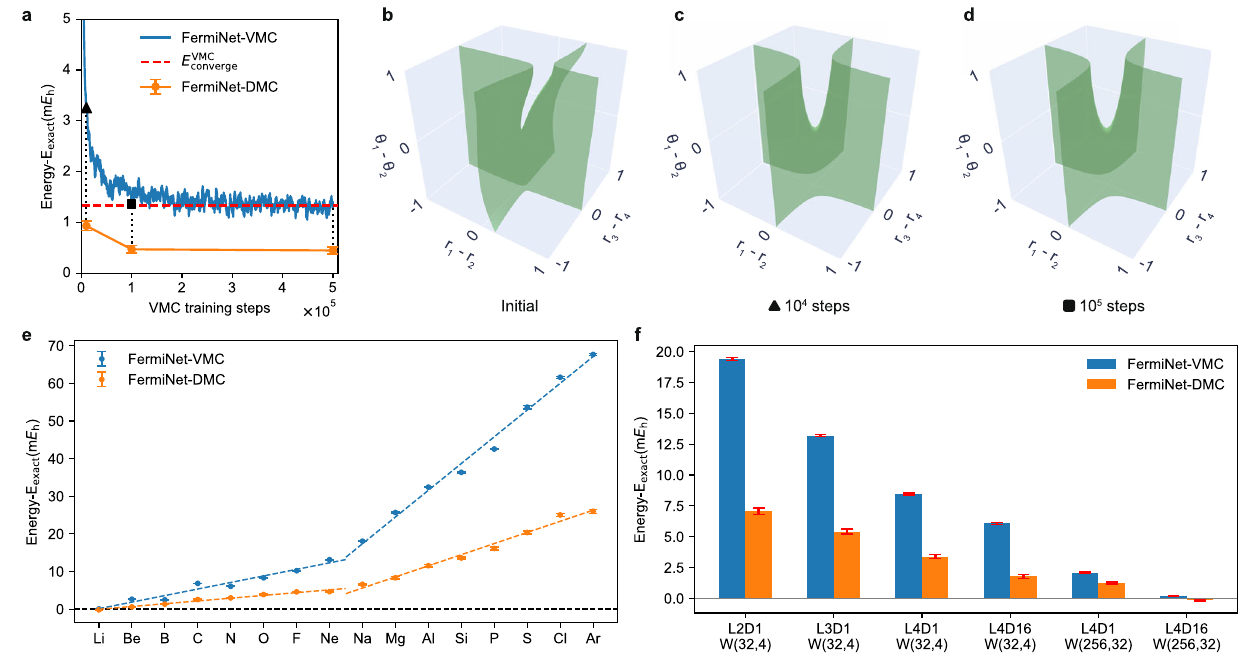
Fig. 2 | Accuracy and ef fi ciency of FermiNet-DMC on single atoms. a The blue line shows the energy of a 2-layer FermiNet as a function of training iteration for a Be atom. The orange symbols show the DMC energy obtained with the trial wavefunction at the 10 4 th, 10 5 th and 5×10 5 th training iteration, respectively. The red dashed line shows the fi nal convergence of VMC energy. b – d The three iso- surfacesshowthethree-dimensionalcutsofthefull11Dnodalstructureobtainedat different training iterations (see Methods, section “ Nodal structure and